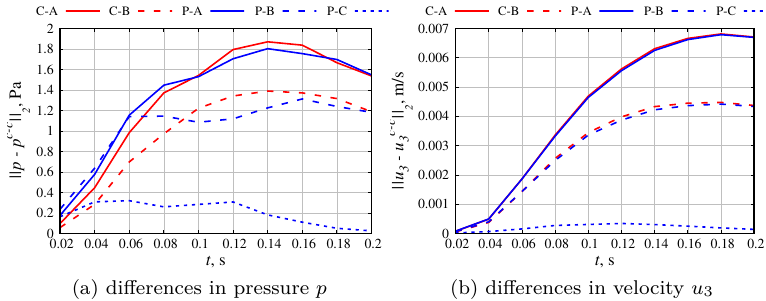
Figure 4. Time evolution of differences in pressure p and velocity u 3 computed in L 2 norm between the numerical solutions obtained with PISO (P-x) and coupled (C-x) schemes on three discrete meshes of increasing size (x-A, x-B,